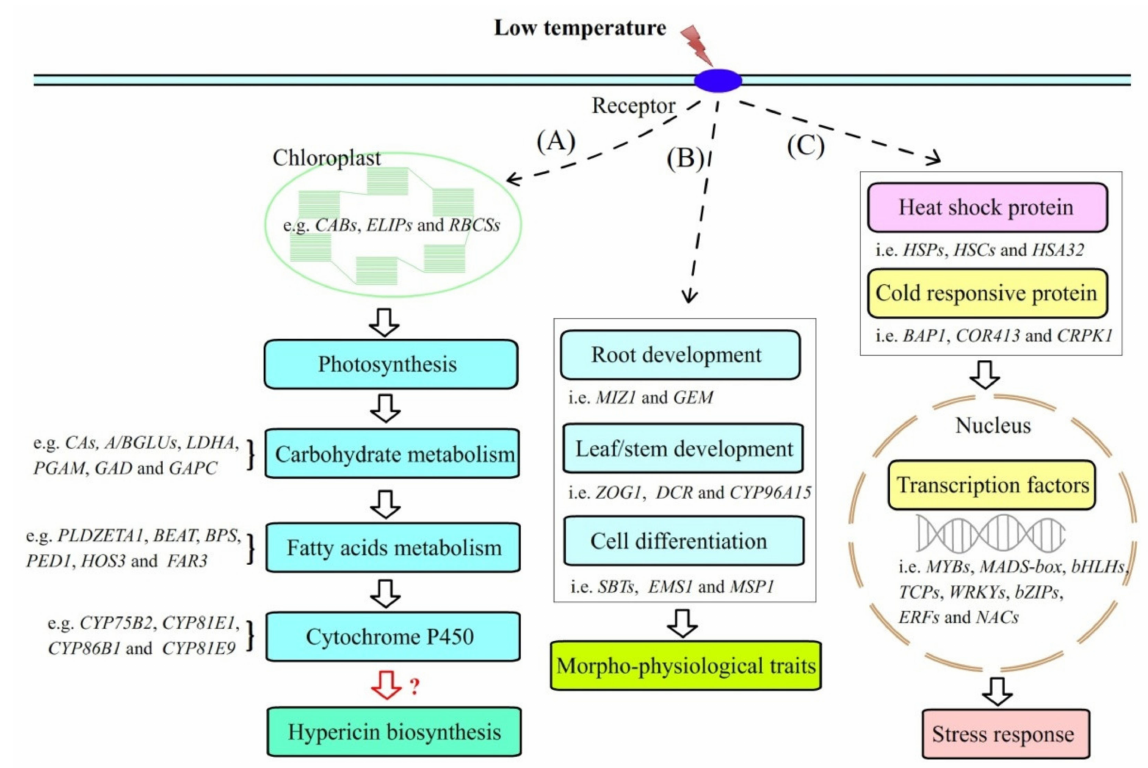
Figure 7. Schematic representation of the proposed pathways of the genes for regulating Hyp biosynthesis, the morpho- physiological traits and the stress response in H. perforatum . Image ( A ) shows the genes involved in Hyp biosynthesis, image ( B ) shows the genes involved in morphophysiological traits, image ( C ) shows the genes involved in stress